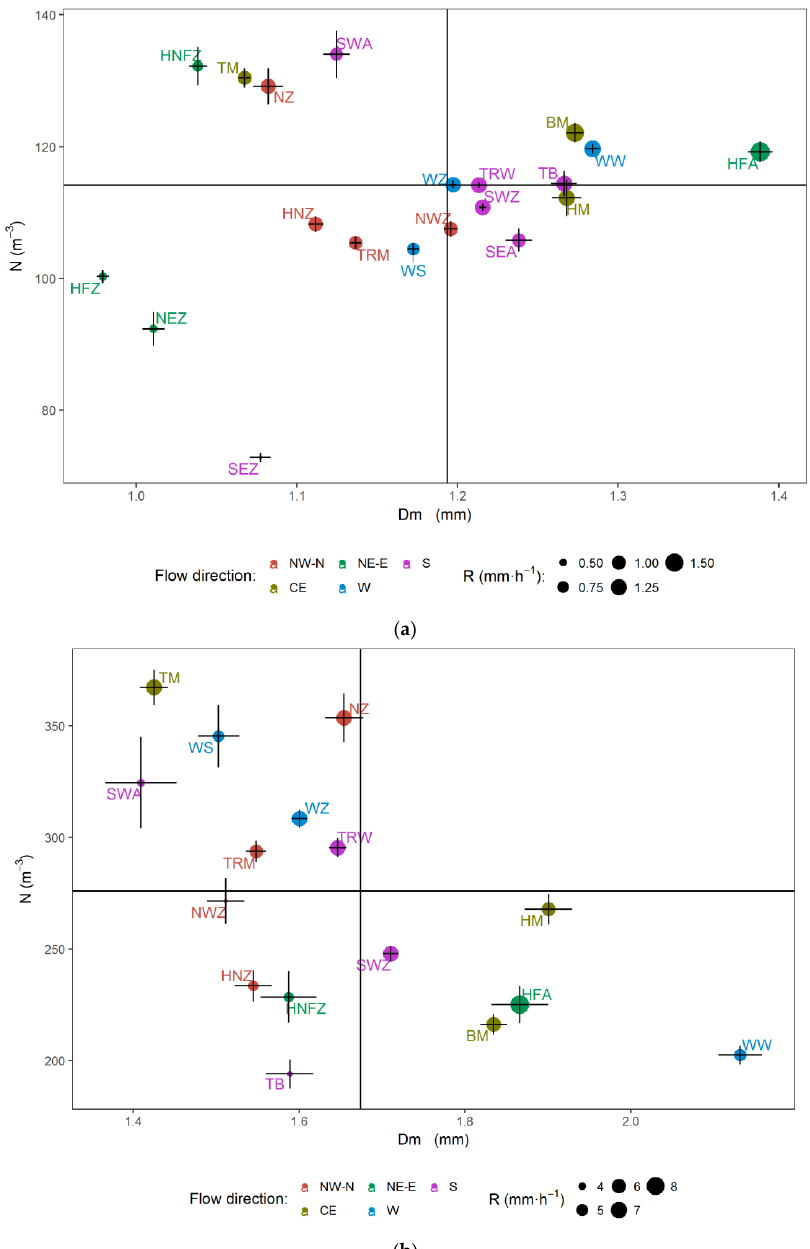
Figure 5. Scatter plot of the rain parameters per GWL with the mean mass weighted diameter (D m ) on the horizontal axis and the mean concentration (N) on the vertical axis. The size of each dot corresponds to the rain intensity (R) associated with a particular GWL. The colors indicate the five considered flow directions (cf. Table 1) in ( a ) stratiform rain and ( b ) convective rain. The horizontal lines represent the standard error of D m . The vertical lines represent the standard error of N.